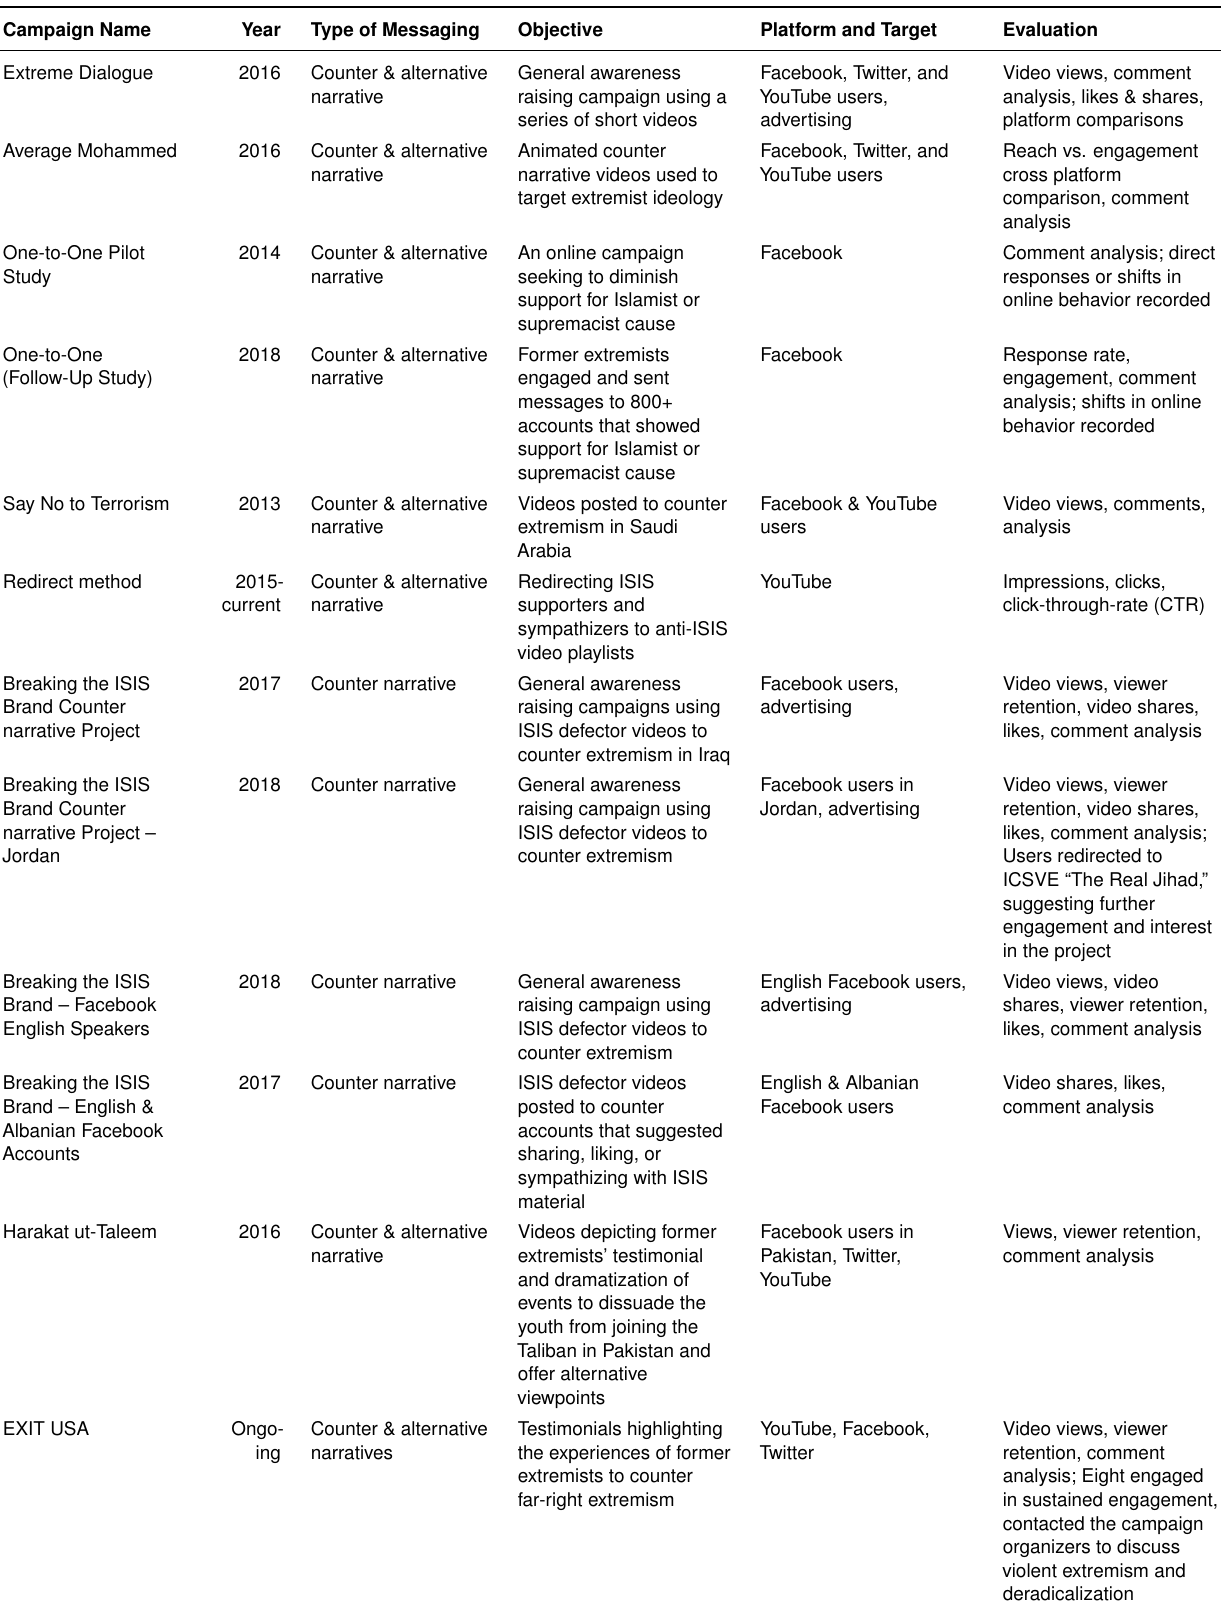
Table 2. Online campaigns and outcomes: Messaging, strategy, and